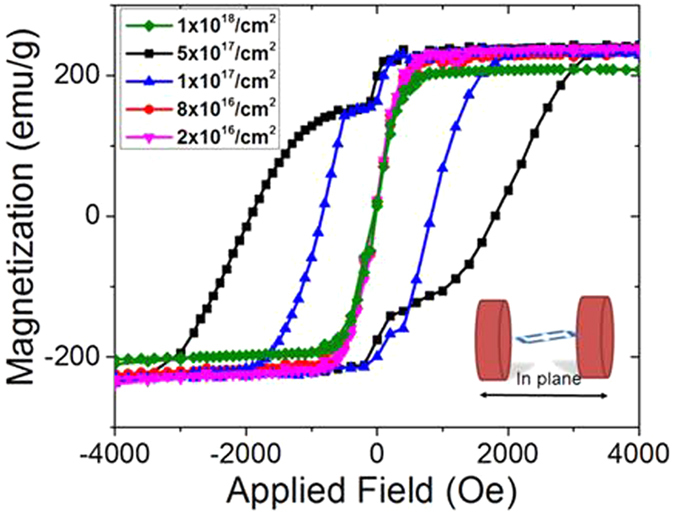
In-plane hysteresis loops for the samples with different fluences at room temperature.Samples with 2 × 1016/cm2, 8 × 1016/cm2 and 1 × 1018/cm2 fluences show soft magnetic property, while samples with 1 × 1017/cm2 and 5 × 1017/cm2 exhibit hard magnetic property.